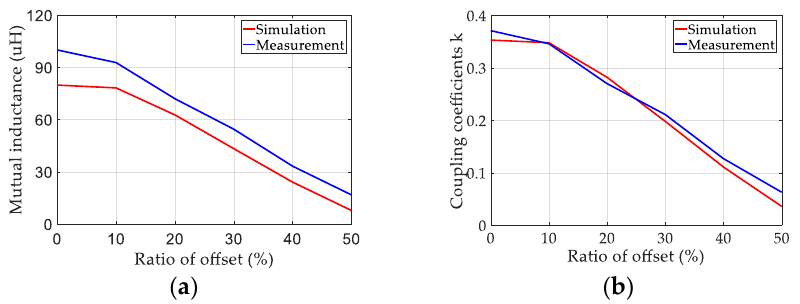
Figure 7. Comparison of simulation and measurement: ( a ) mutual inductance; ( b ) coupling coefficients.